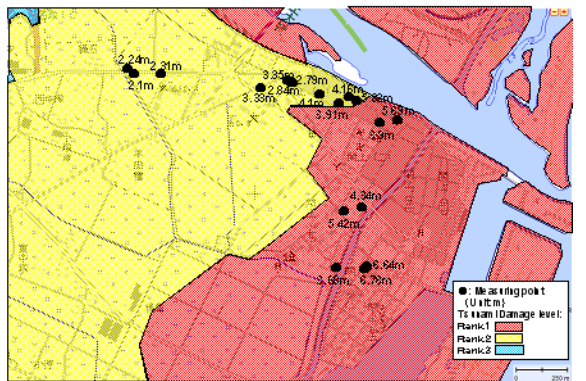
Figure 4. Tsunami flooded depth measured by MMS at Yuriage